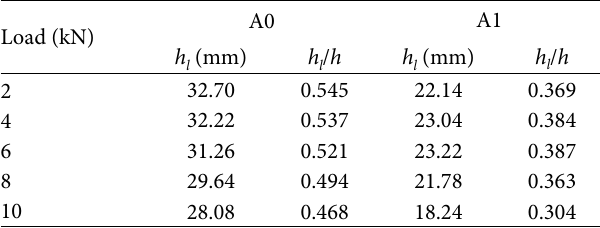
Table 4: Positions of neutral axis under different loads in the first series.